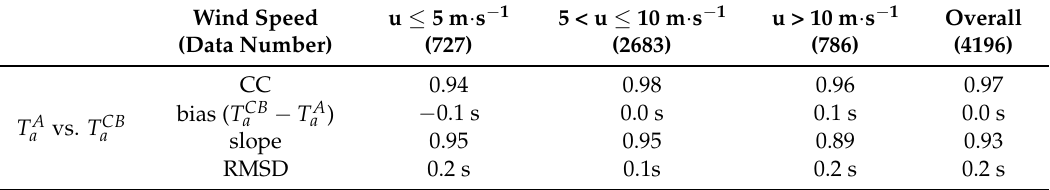
Figure 9. Amount of data for the 16 data subsets.